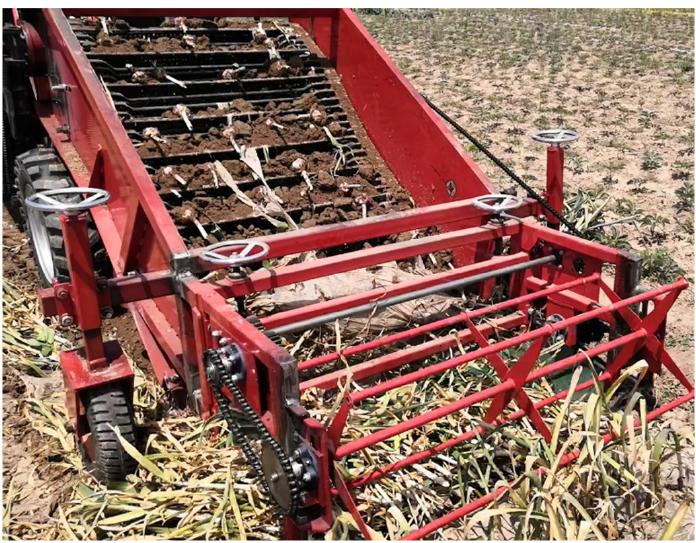
Figure 7. Photo of field test.